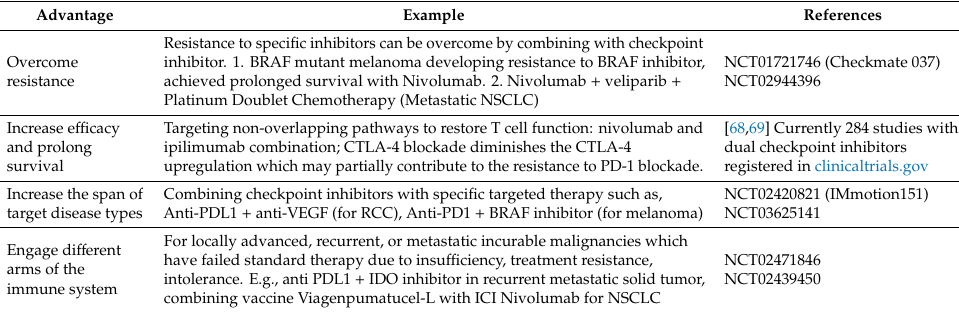
Table 2. Examples of selected benefits of combination